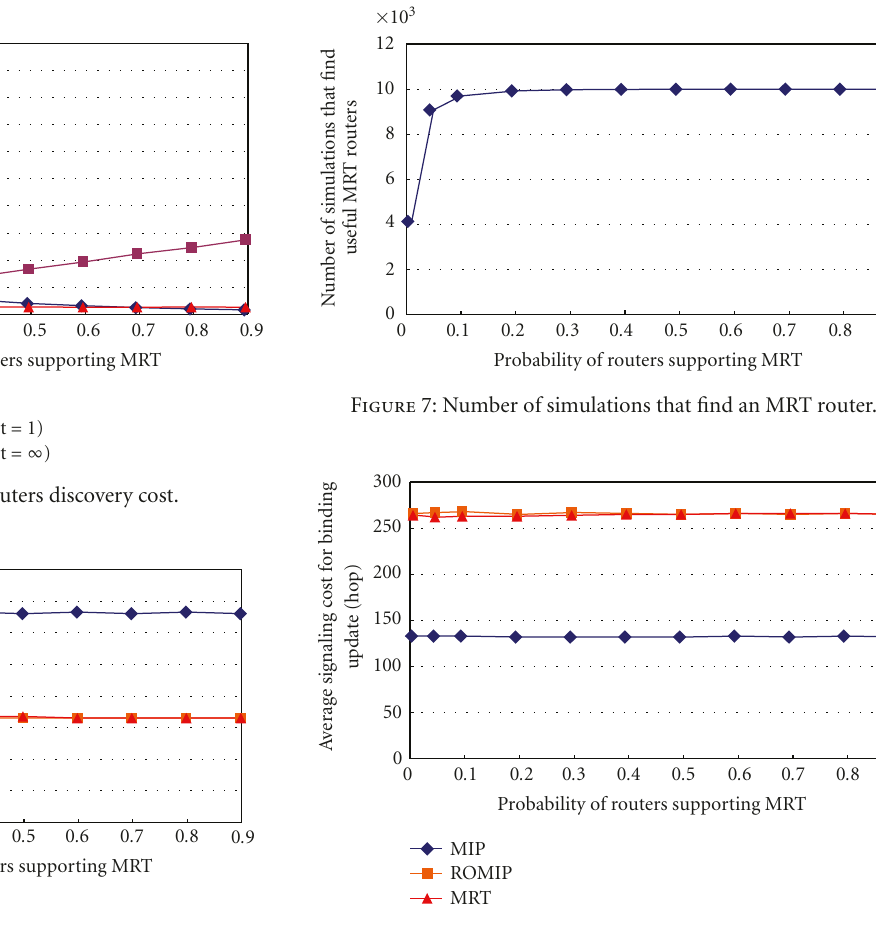
Figure 8: The hando ff cost versus the probability of routers supporting